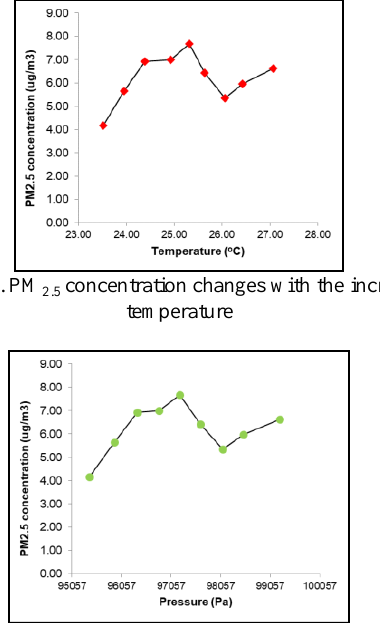
Figure 17. PM 2.5 concentration changes with the increase of